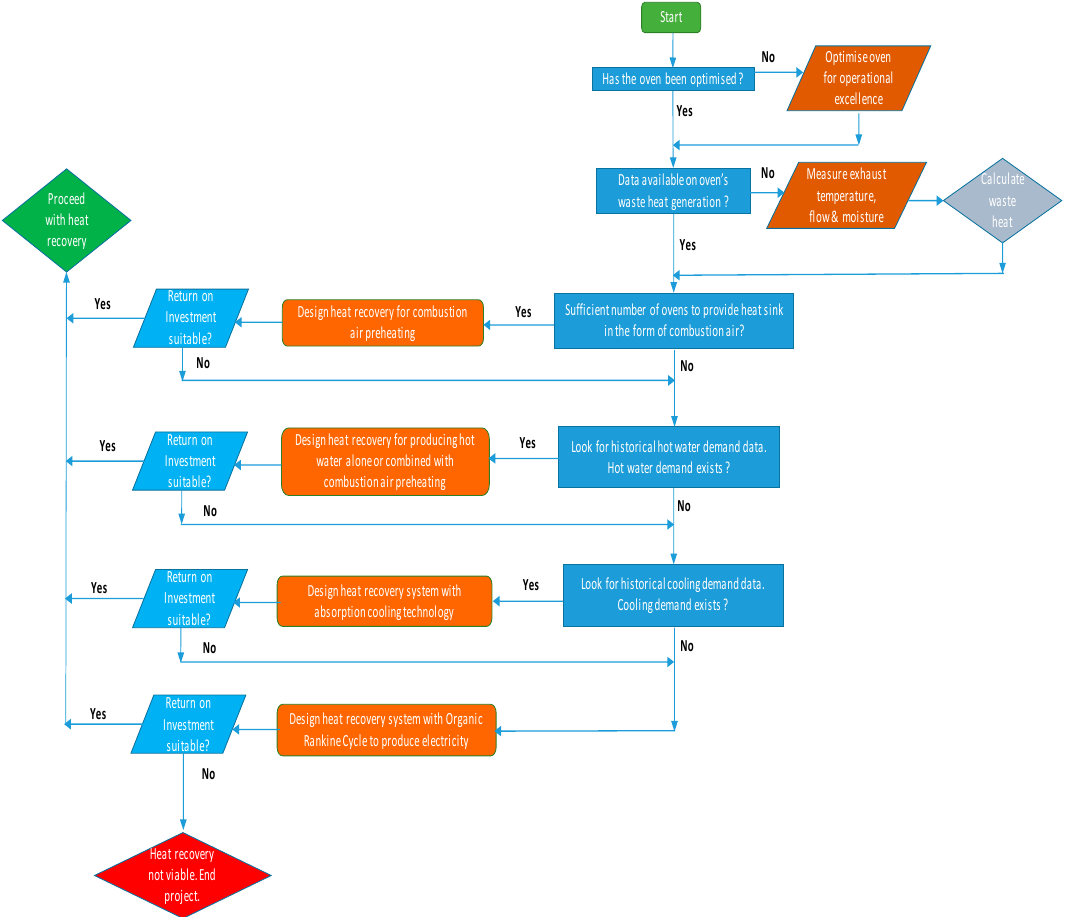
Figure 12. Process map for the selection of suitable heat recovery technology.